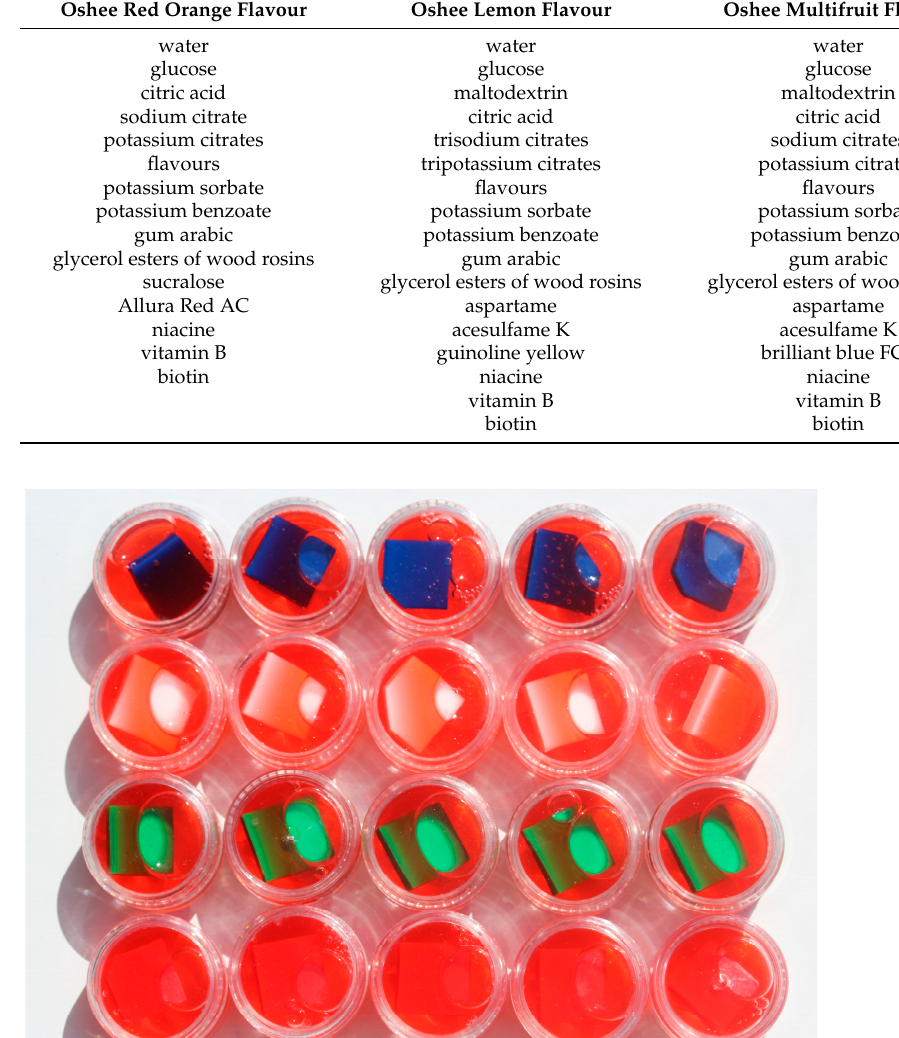
Figure 2. EVA samples in separate containers in isotonic drink (Oshee Red Orange Flavour).